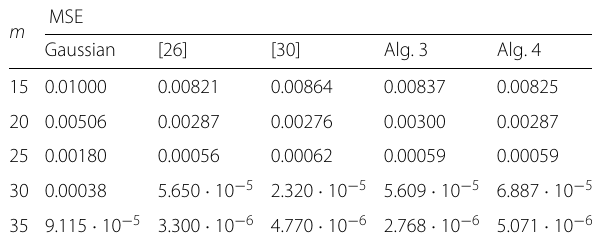
Table 2 MSE for sparse signals of length N = 120 obtained with CS, for variable number of measurements, m = 15 : 5 : 35, and various types of sensing matrices MSE m